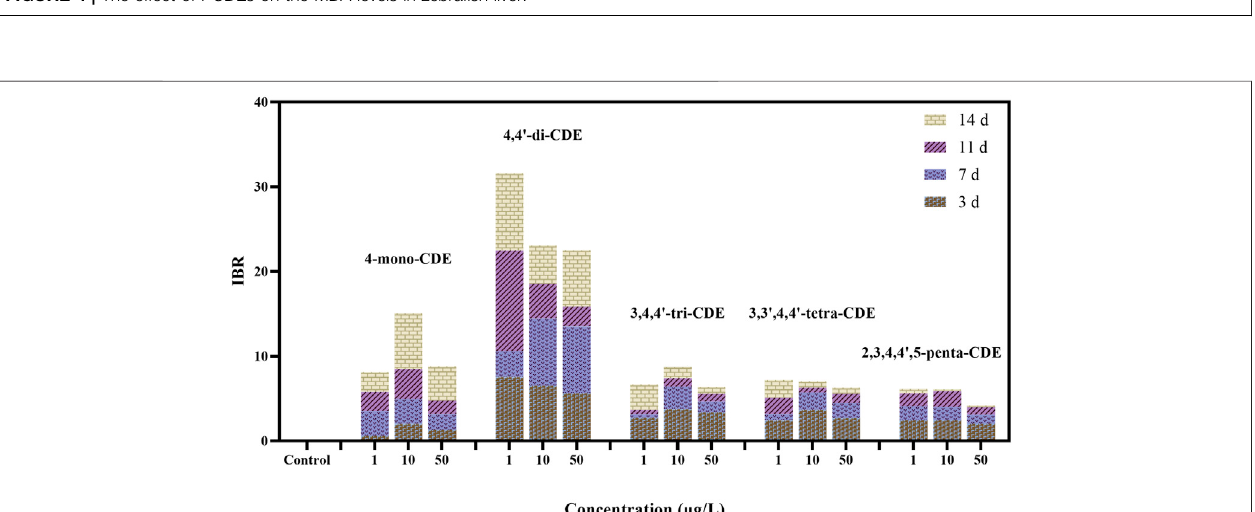
FIGURE 5 | The calculated IBR values of PCDEs for different doses after 14 days of exposure.